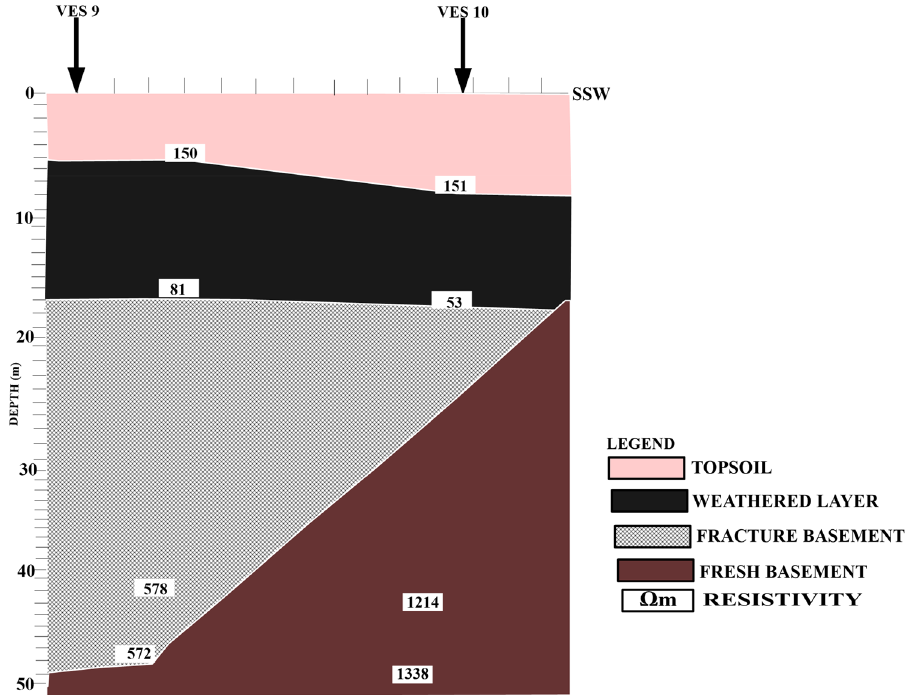
Figure 8. 2D Geoelectric Section along NNE–SSW Cross